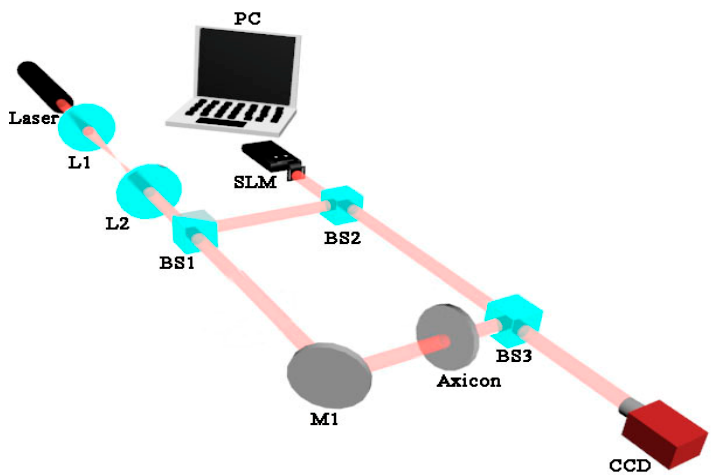
Figure 1. Experiment setup of phase-shifting digital holography for measuring the base angle of axicon. SLM: Spatial light modulator; CCD: Charge coupled device.